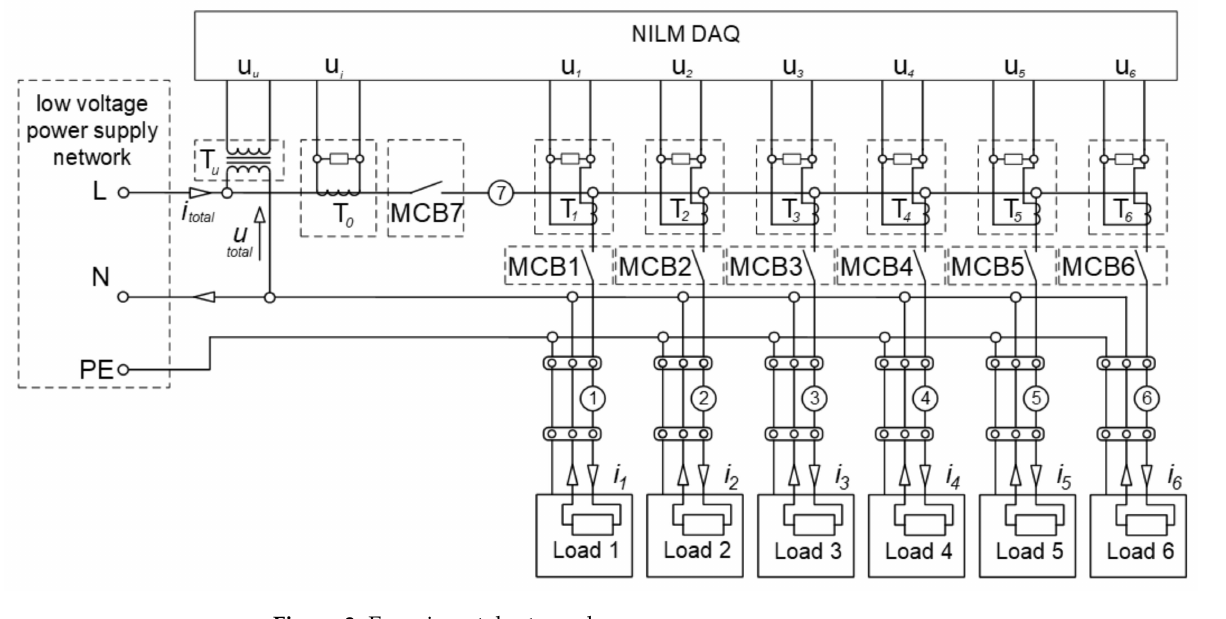
Figure 3. Experimental setup scheme. Table 1. Characteristics of the tested electrical appliances.